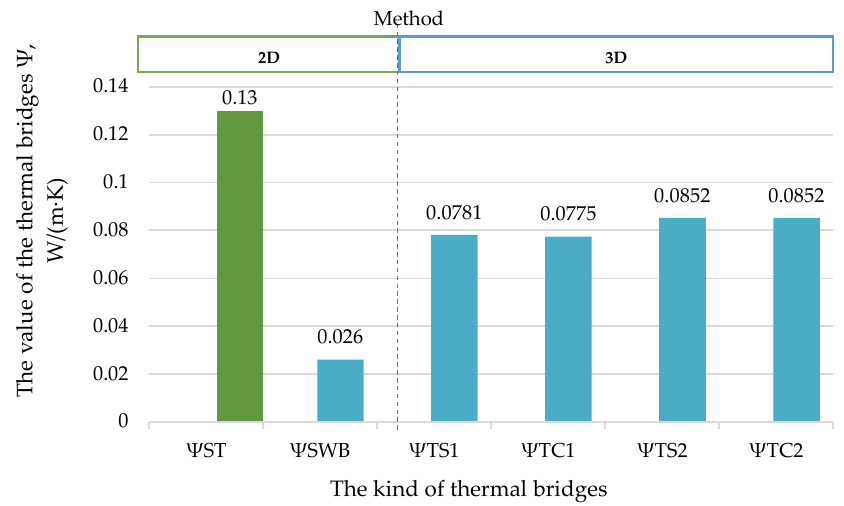
Figure 12. Comparison of the values of thermal bridges analyzed using different calculation methods.